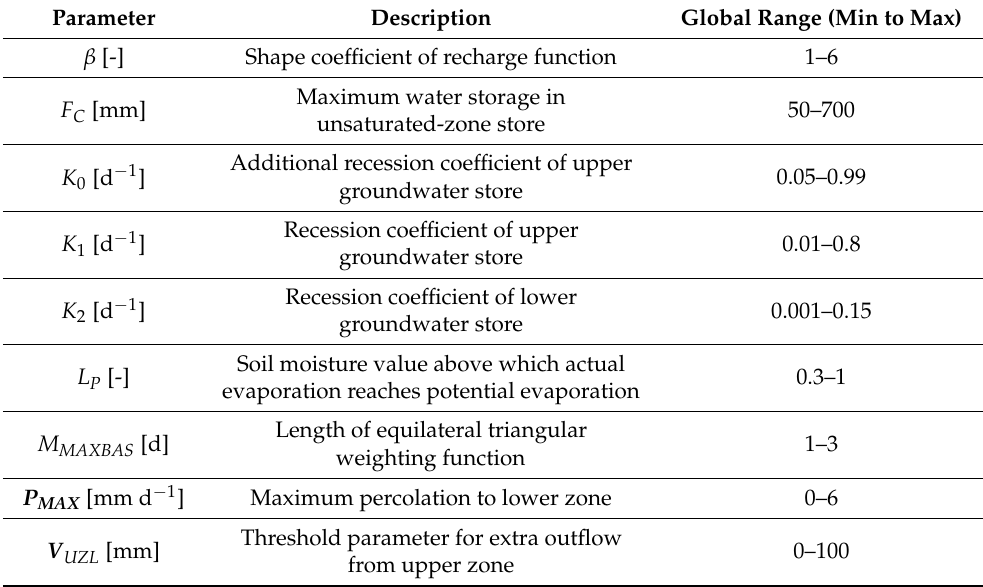
Table 3. HBV parameter ranges for the RVLB and their descriptions, derived from Beck et al.